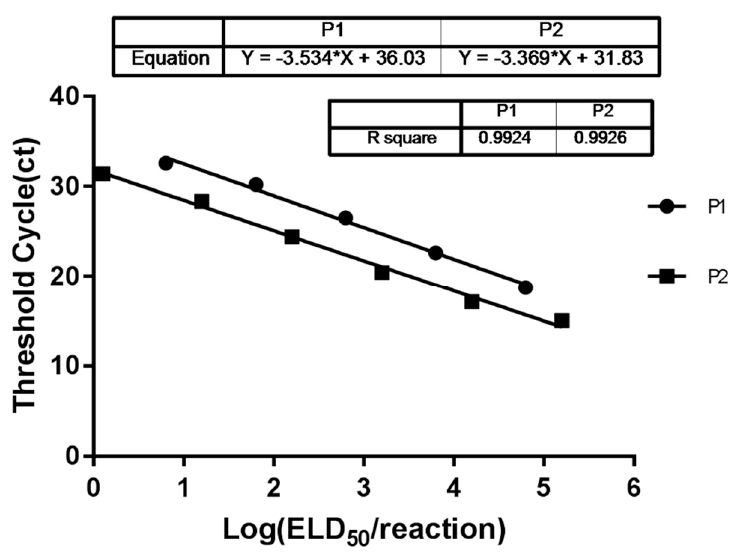
Figure 1. Standard curves of the developed real-time RT-PCR assay using B87 (P1) and BC6/85- specific probes (P2). Each point represents the mean Ct of three different measurements. The coefficients of determination R 2 are indicated. Table 3. Variability of B87 and BC6/85